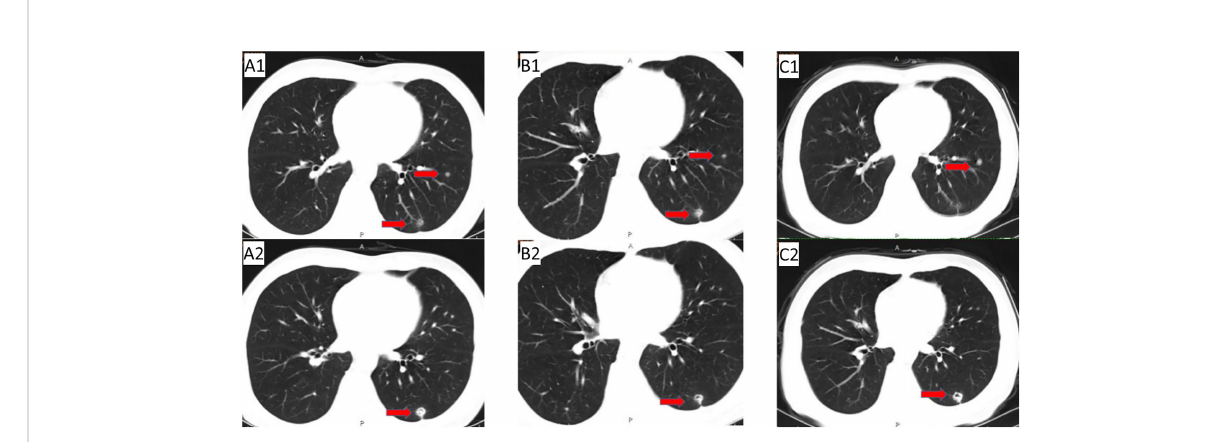
FIGURE 2 The period from the progression of lung metastasis to before the application of anlotinib + TAS-102 treatment: (A1/A2) Follow-up CT (2020.06.12): multiple nodules in bilateral lung; (B1/B2) CT (2020.08.12) after 1 cycle of second-line treatment; (C1/C2) initial application of cetuximab + TAS-102 in the third line, and discontinuation due to adverse reactions after only 2 cycles of cetuximab. On November 24, 2020, reexamination of CT showed that pulmonary nodules were increased and enlarged than